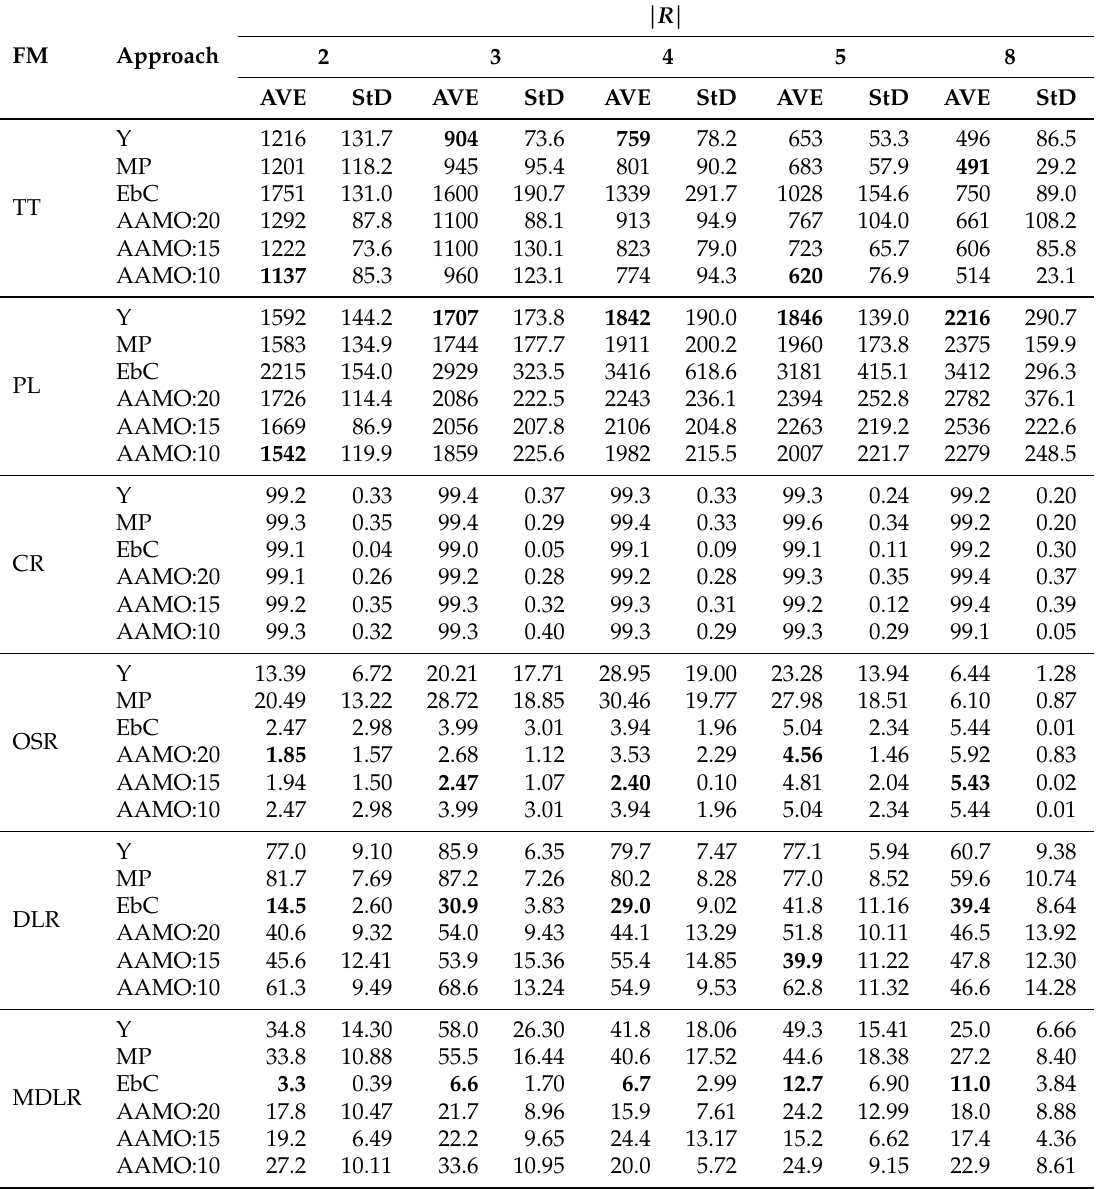
Table 5. AAMO Results obtained under non-ideal communication conditions on Maze